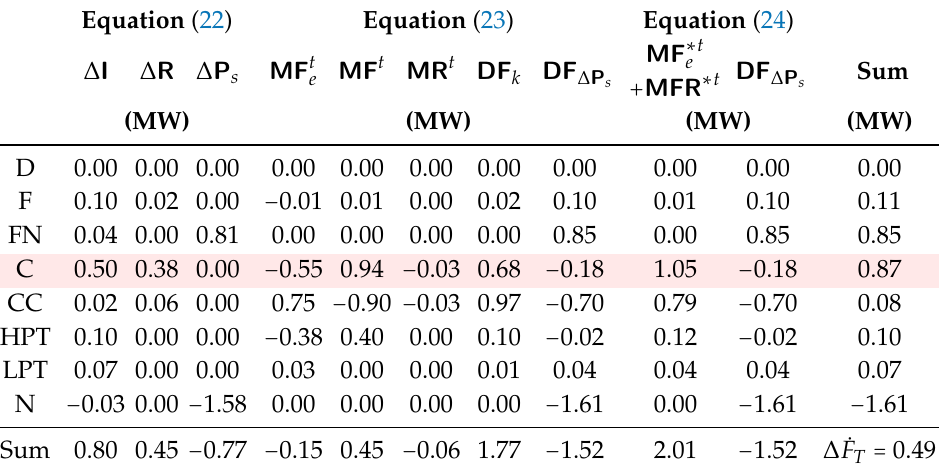
Table 7. Fuel impact